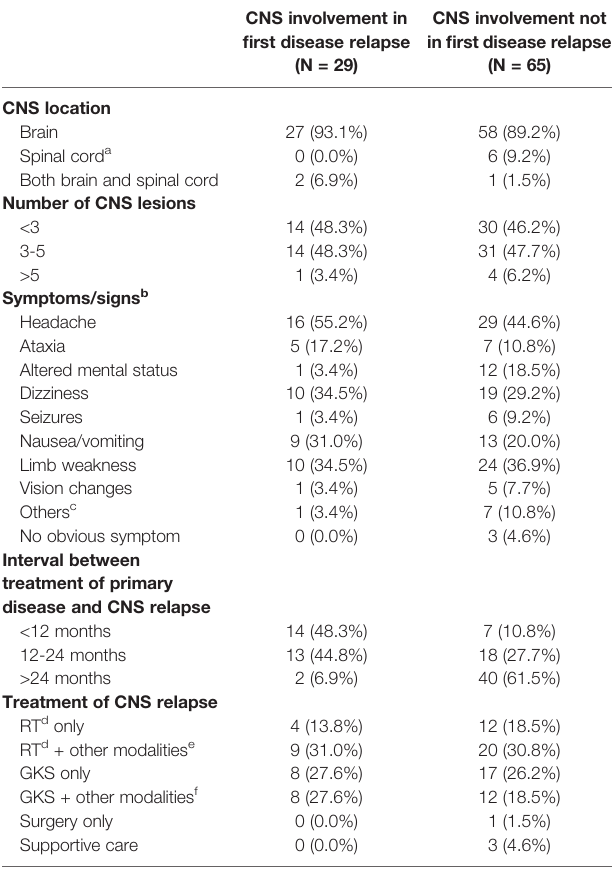
TABLE 2 | Clinical characteristics of ovarian cancer patients with CNS metastases (94 cases). CNS involvement in fi rst disease